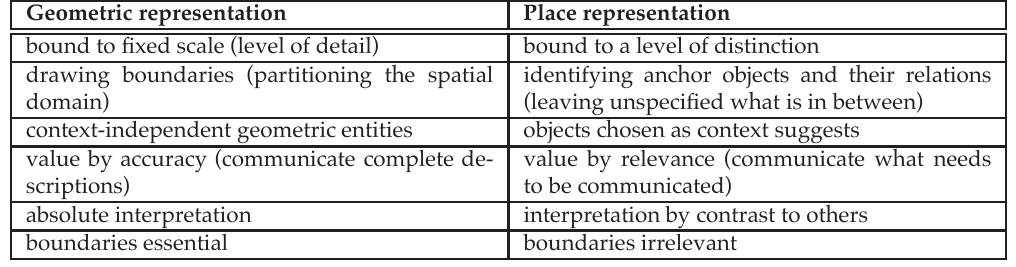
Table 1: Comparing geometric representations of entities in databases and representations in place